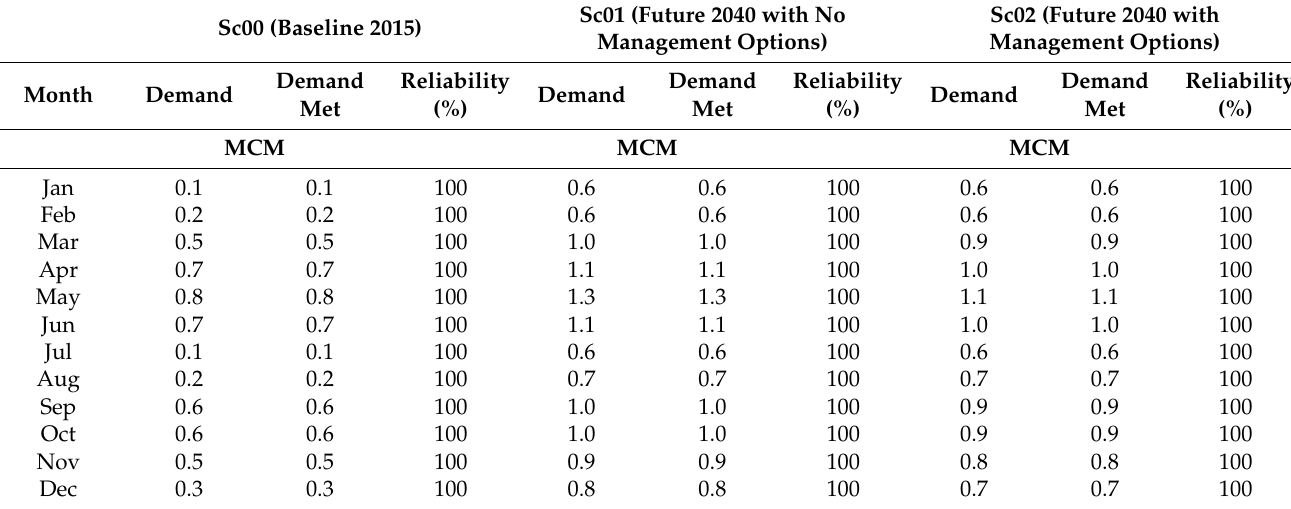
Table 10. Mubuku water use reliability for the three scenarios.